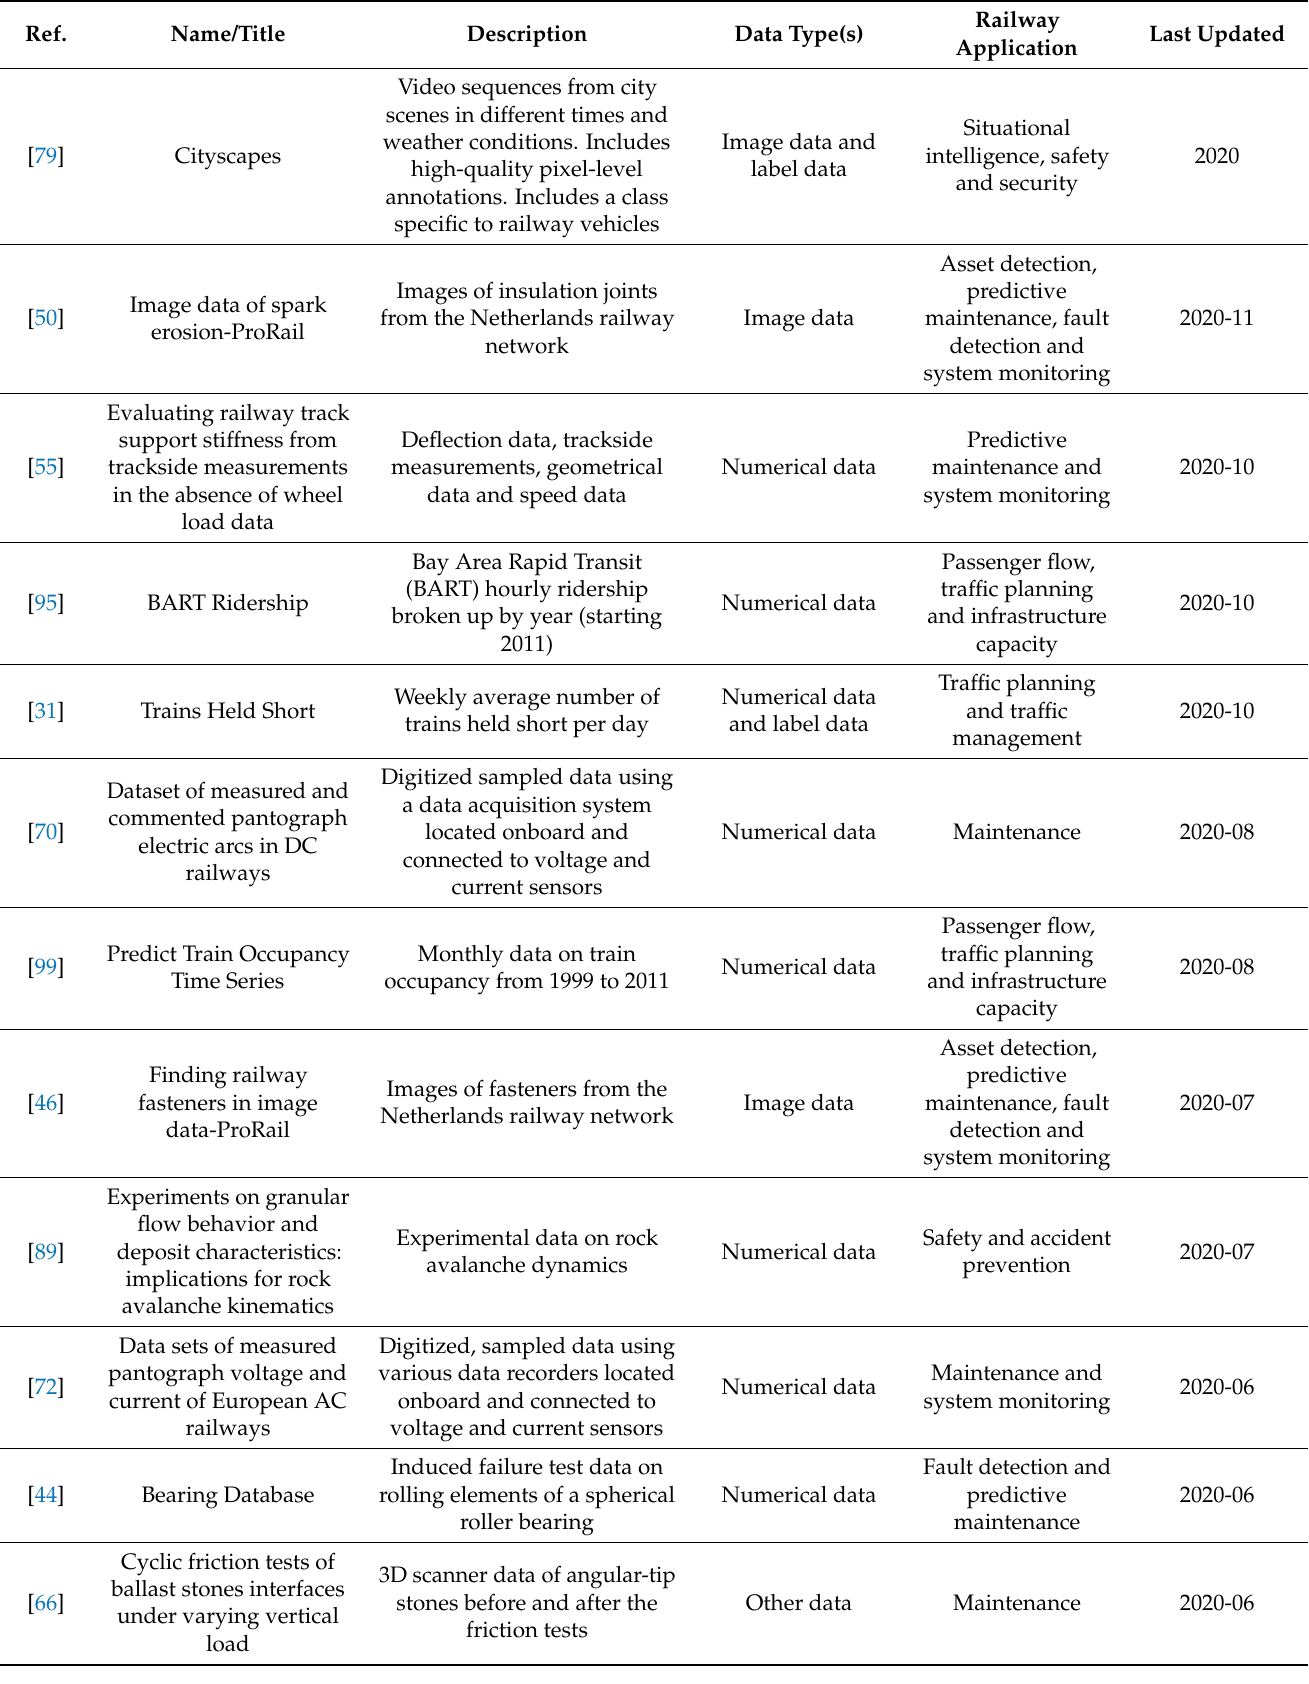
Table A1. List of all 62 datasets consulted for the review.